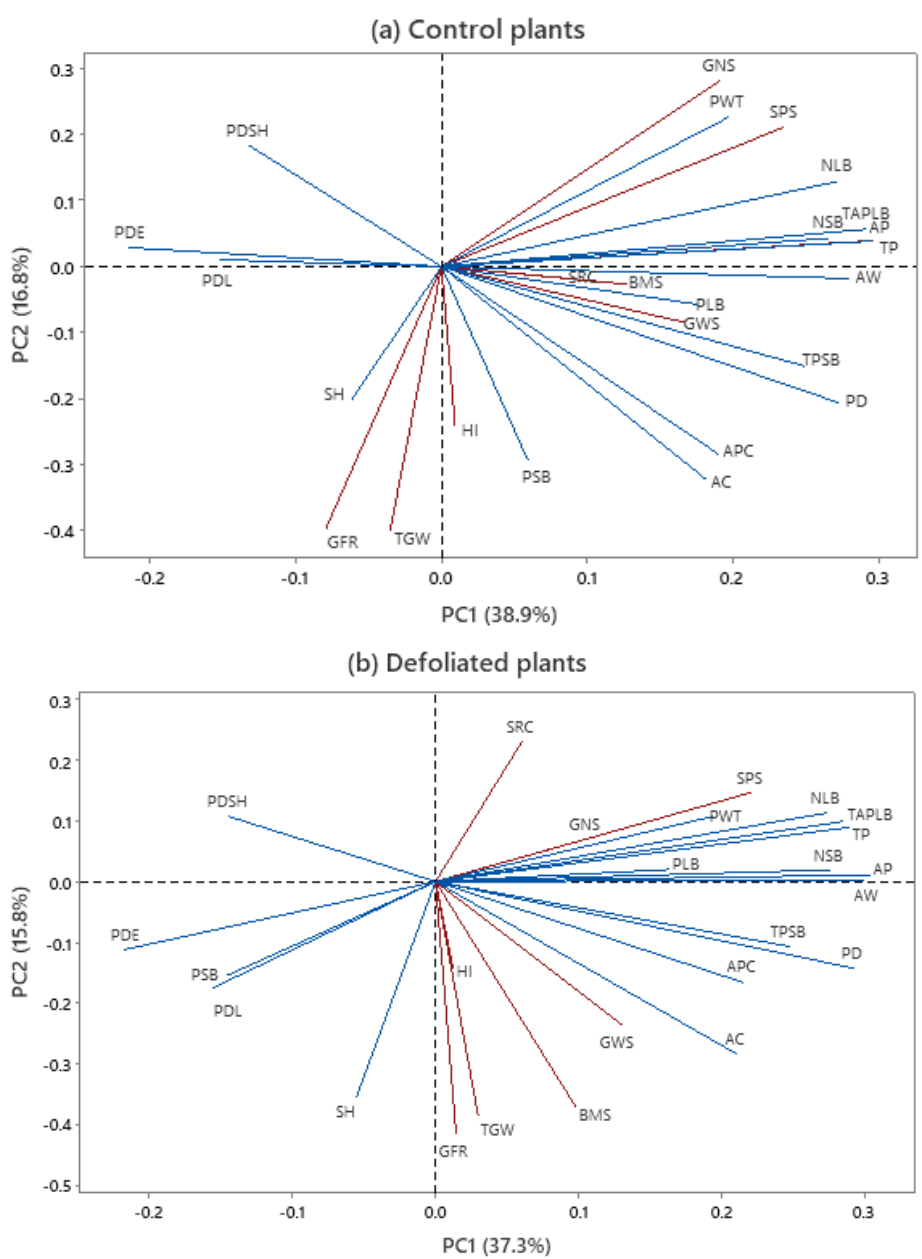
Figure 3. Genotype-by-trait biplot with interrelationship among traits in control (CP) and defoliated plants (DP) based on mean values across 20 genotypes and 2 growing seasons. Trait acronyms: